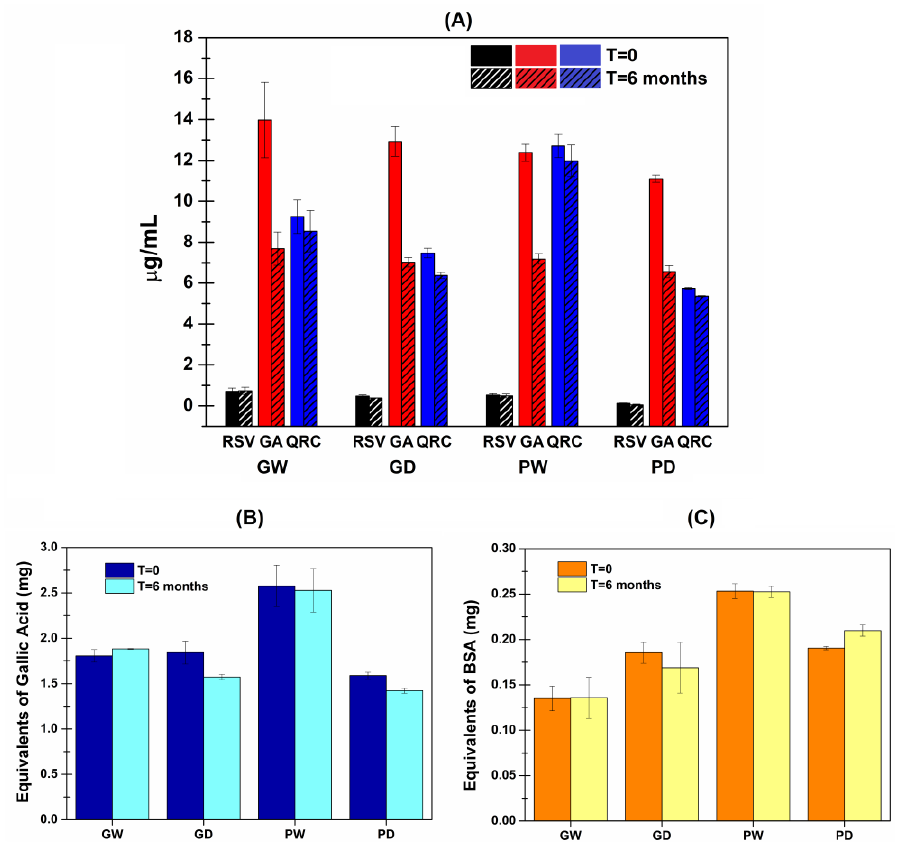
Figure 6. Stability evaluation by comparation of the quantitative analyses conducted on the